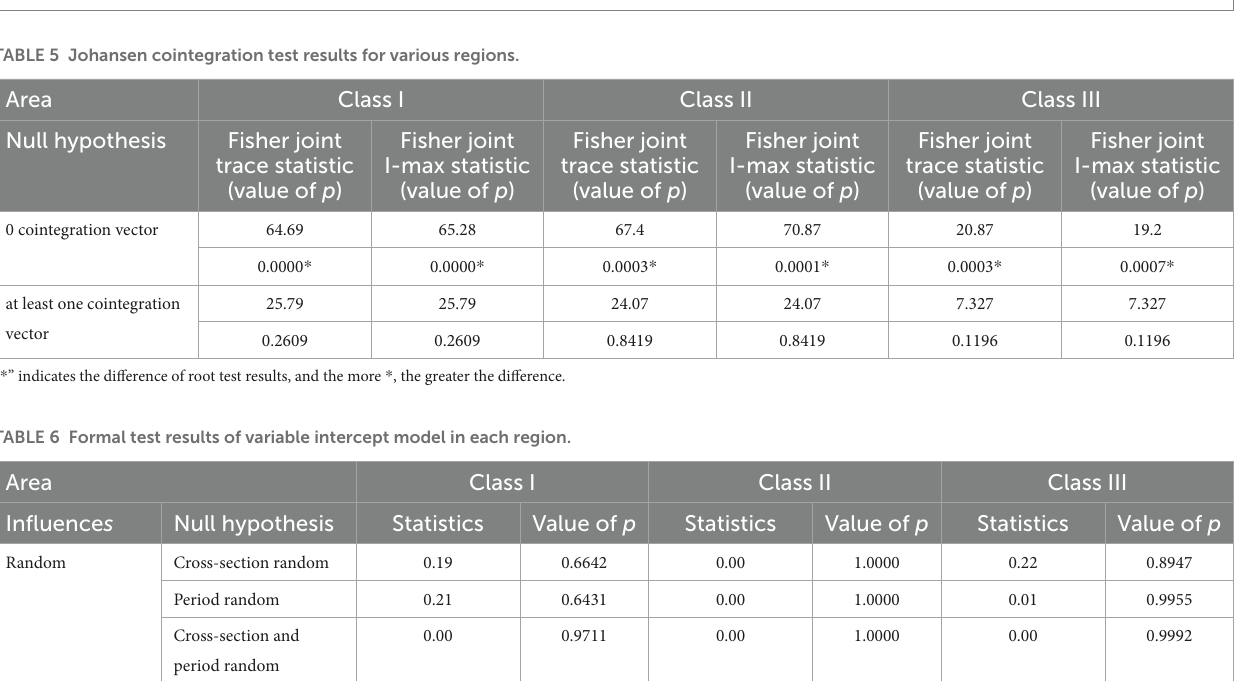
FIGURE 5 Comparison of coefficients in Class III